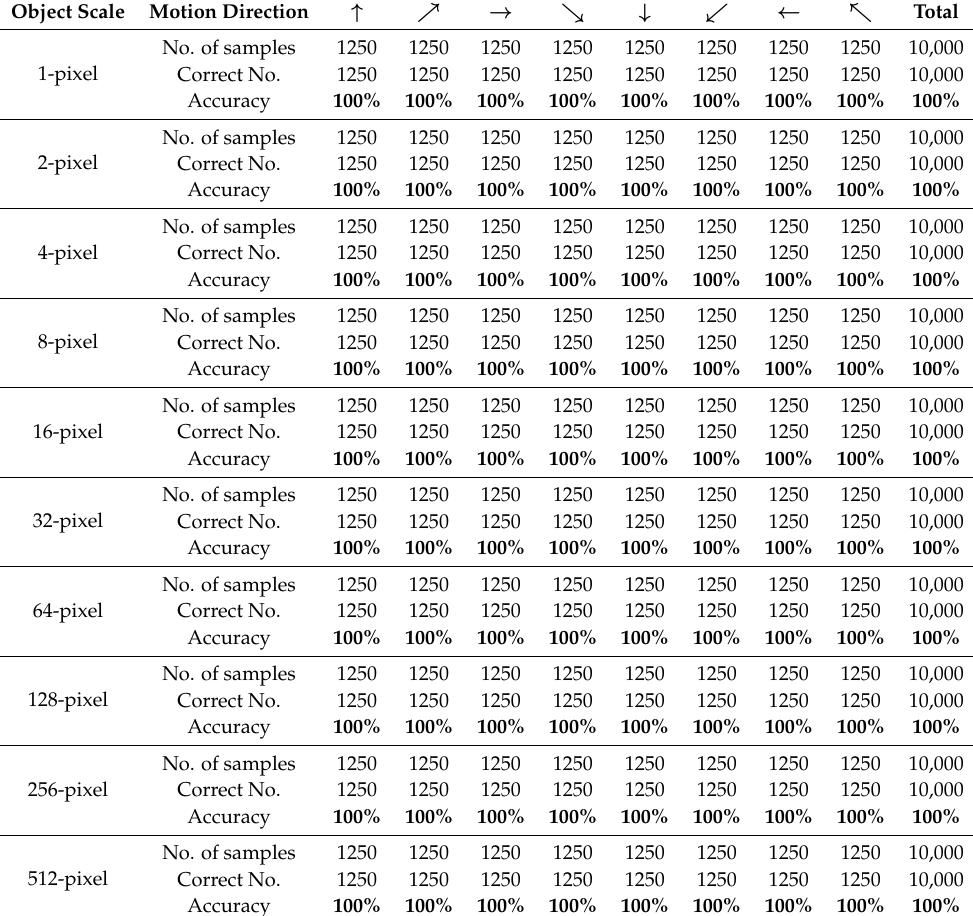
Table 1. Experimental results of AVS on motion direction detection with different scales of object. Object Scale Motion Direction